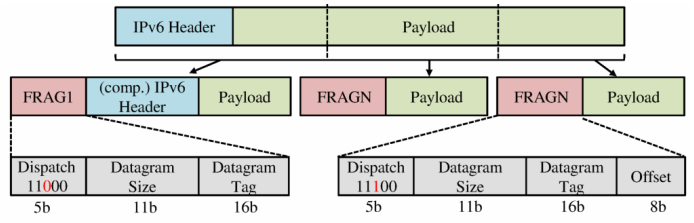
Figure 3. Packet fragmentation—adapted from